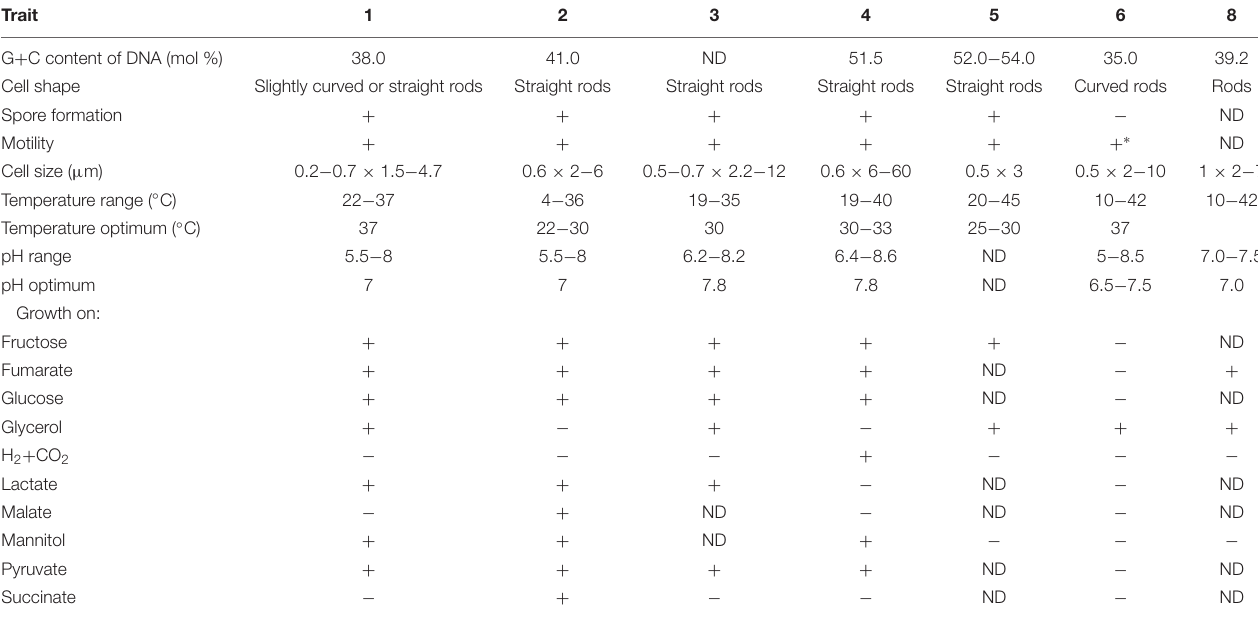
TABLE 4 | Distinguishing features of strain UFO1 compared to the most closely related described species in the Class Negativicutes. Trait 1